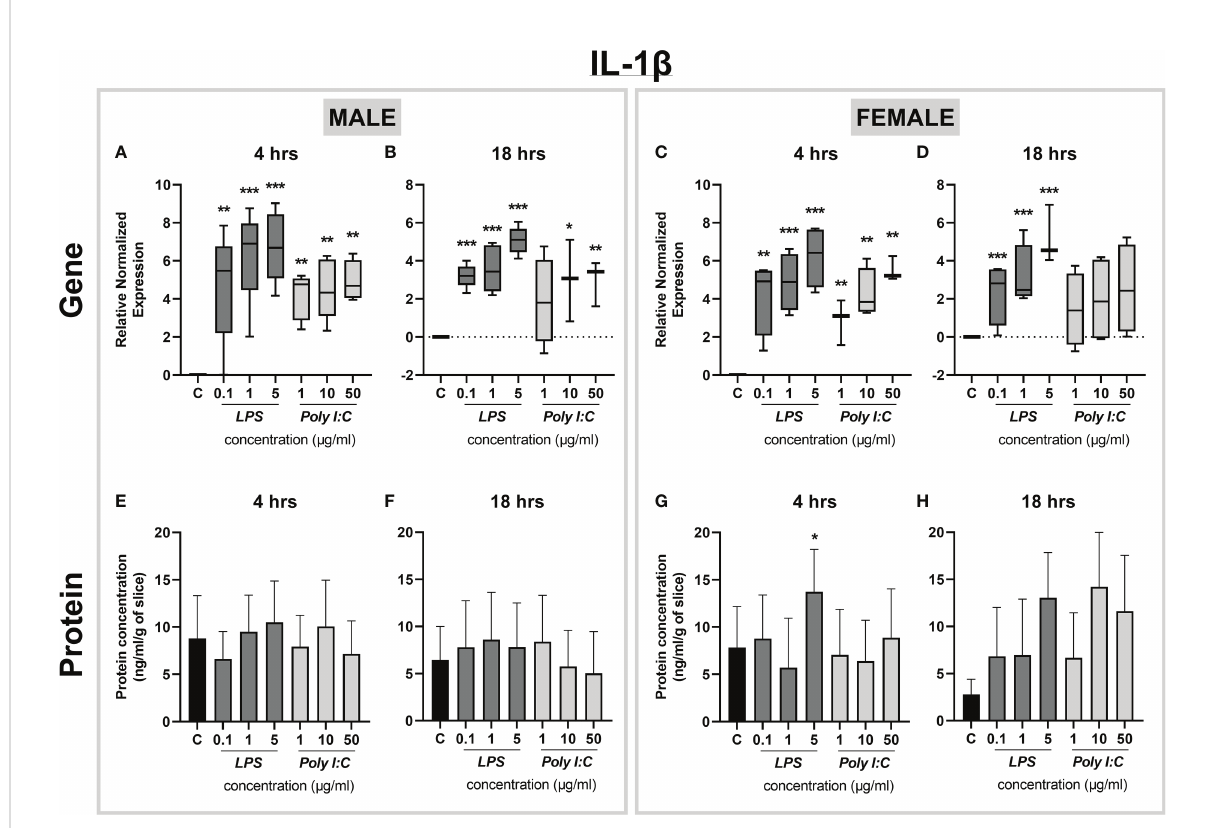
FIGURE 5 Effect of LPS and Poly I:C on IL-1 b gene expression and protein concentration. Male and female placental slices were exposed to LPS and Poly I: C at various concentrations for 4 and 18 hours. Gene expression of Il-1 b in placental slices was evaluated by qPCR analysis (A-D) . IL-1 b protein concentrations were measured in culture media using a commercially available ELISA kit (E-H) . Data are shown as Tukey boxplots or mean ± SEM; n ≥ 3. *P < 0.05; **P < 0.01; ***P <